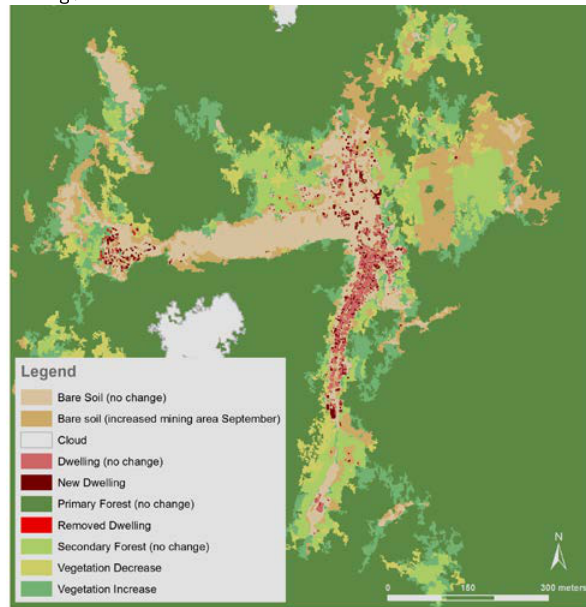
Fig. 3 . Results of the land cover change from April 2010 to September 2010.